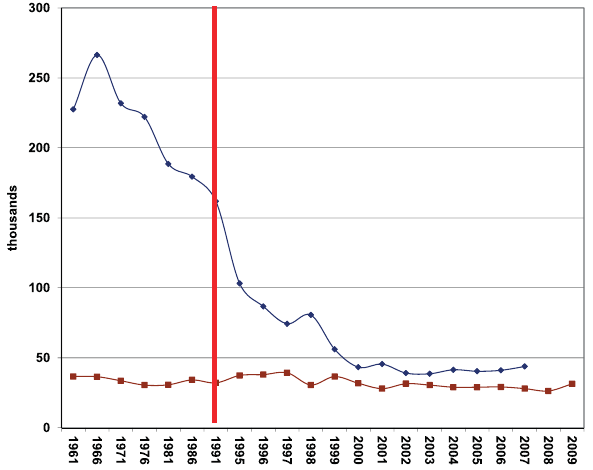
Fig. 8. A comparision of domesticated reindeer populations in different forms of ownership in the Siberian taiga; Enter- prises ( ―♦ ), Households ( ―■ ). In contrast to tundra regions, the number of reindeer held by enterprises in Siberian taiga zone began to fall long before the post-Soviet crisis. Re- cently, the population has leveled off at a low number. In the last fifty years, the number of reindeer owned by herders’ households has been consistently low. Reindeer husbandry in several taiga localities is now endangered or has even dis-